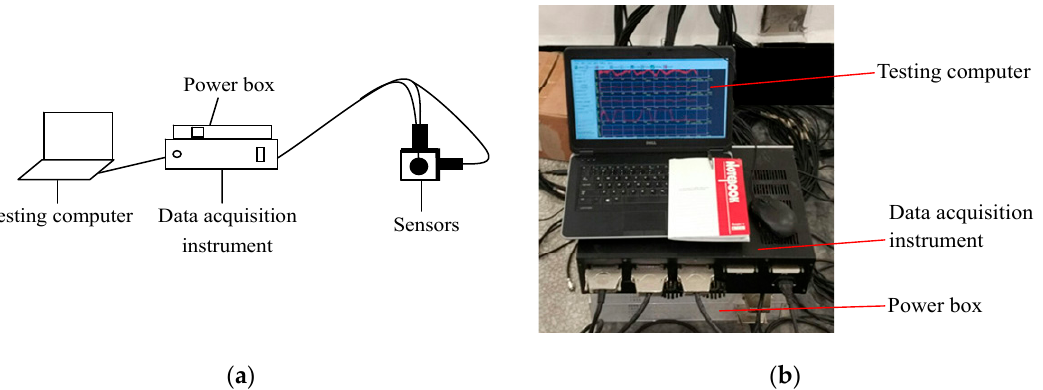
Figure 3. Data acquisition instrument: ( a ) Schematic; and, ( b ) Field tests photo.